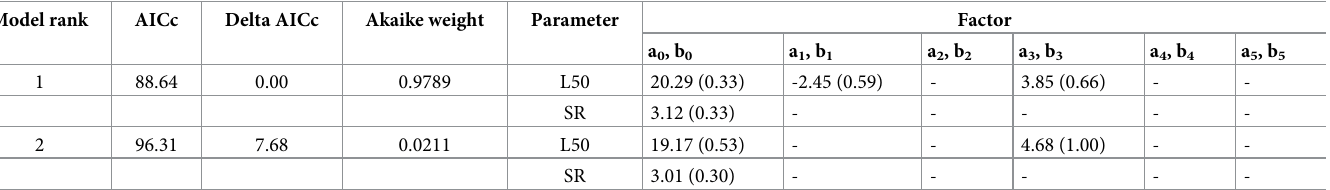
establish the predictive model for L50 and SR . A single model gave AICc values within +10 of the model with the lowest value (Table 7). strong influence on predicted L50 values. The negative value of factor a indicates that the 1 switch from the SM40 to the DM50 codend resulted in lower L50 values, whereas the positive value of a predicted higher L50 values in summer than in spring. Neither codend design nor 3 The model for Norway lobster (Table 7) reasonably agreed with the experimental results, sup- porting its value in making predictions for this species (Fig 6). The pairwise comparisons of the predicted size selectivity curves for Norway lobster are shown in Fig 7. A difference in selectivity between the two codends was predicted only for spring, where the CI did not overlap. Deep-water rose shrimp. Of a total number of 25,563 individuals of deep-water rose shrimp, 13,906 were caught with the SM40 gear (2959 length measured) and 11657 with the DM50 codend (2557 length measured). Data from 27 considered hauls (Table 8) for which it was possible to obtain a size selection curve (Table 9) were used to calculate the predictive model. In one case, the logit curve (1) failed to fit the experimental data (p–value < 0.05), but given the absence of systematic patterns in residuals the discrepancy between data and model is probably due to overdispersion in the data [24]. Table 7. Description and model ranking based on the full model (Eq 2) for Norway lobster. Model rank AICc Delta AICc Akaike weight Parameter Factor